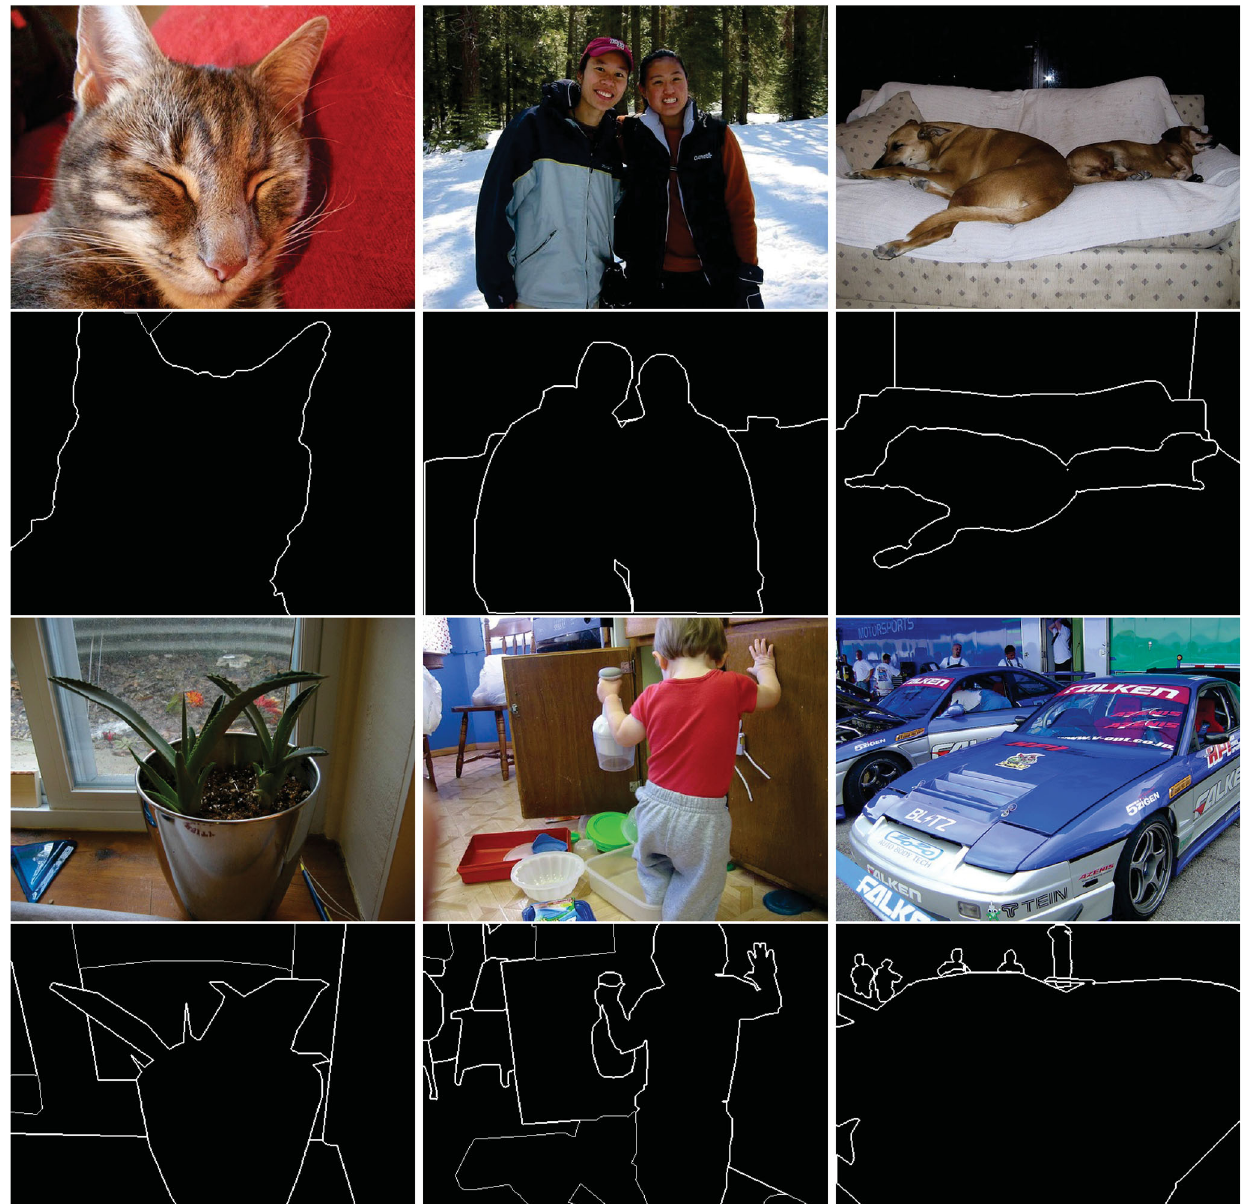
Fig. 4 Images and ground-truths for the Pascal Context dataset. Rows 1,3: original images. Rows 2,4: corresponding annotated